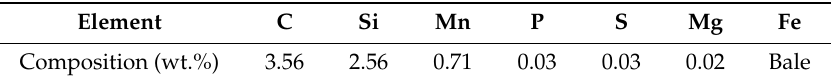
Table 1. Chemical compositions of nodular cast iron.